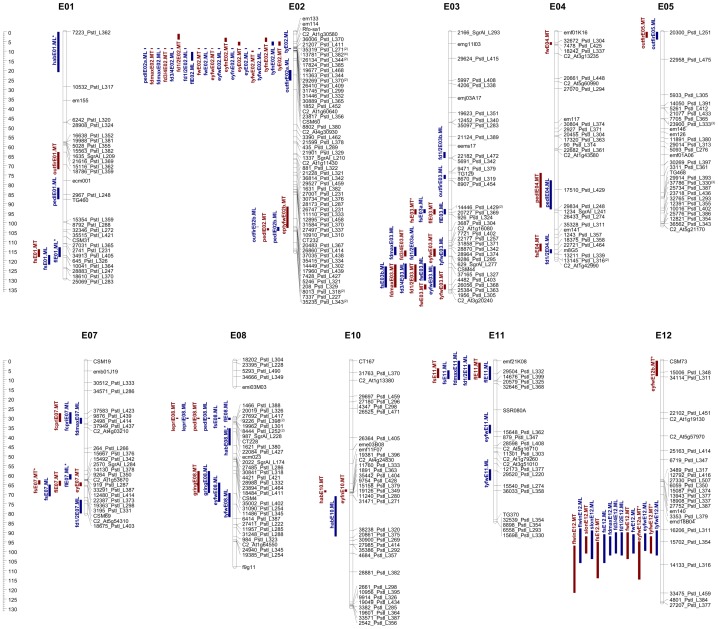
QTL location (only chromosomes harboring QTL are shown).The scale shown on the left indicates the chromosome length in cM. Marker names are shown to the right; the inclusion of a superscript near a marker name indicates the presence and number of additional co-localizing markers on the Barchi et al. (2012) map. Map positions of the QTL are given on the left of each chromosome. The length of the vertical bars represents the QTL confidence interval. QTL shown in blue were detected at ML, and those in red at MT. Epistatic QTL are prefixed by “*” where the QTL had already been detected by MapQTL software, and by “ep” where the QTL was newly detected.